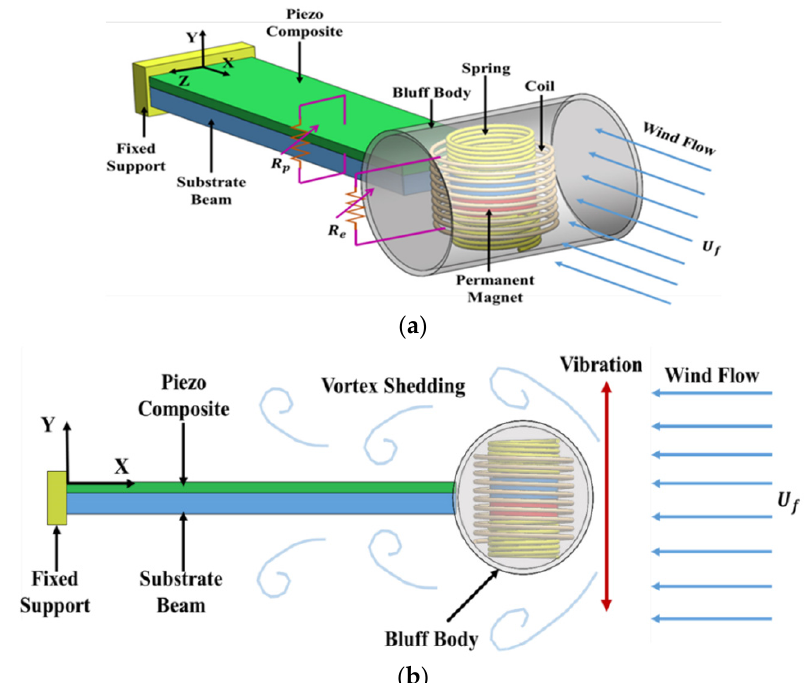
Figure 2. A schematic of a single VIV-based hybrid energy harvester: ( a ) 3D view; ( b ) side view. The electromagnetic harvester is embedded inside the bluff body.